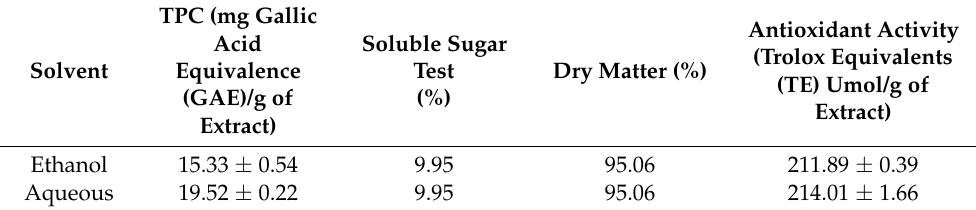
Table 3. Chemical traits of two different extracts of Eucalyptus Camaldulensis.